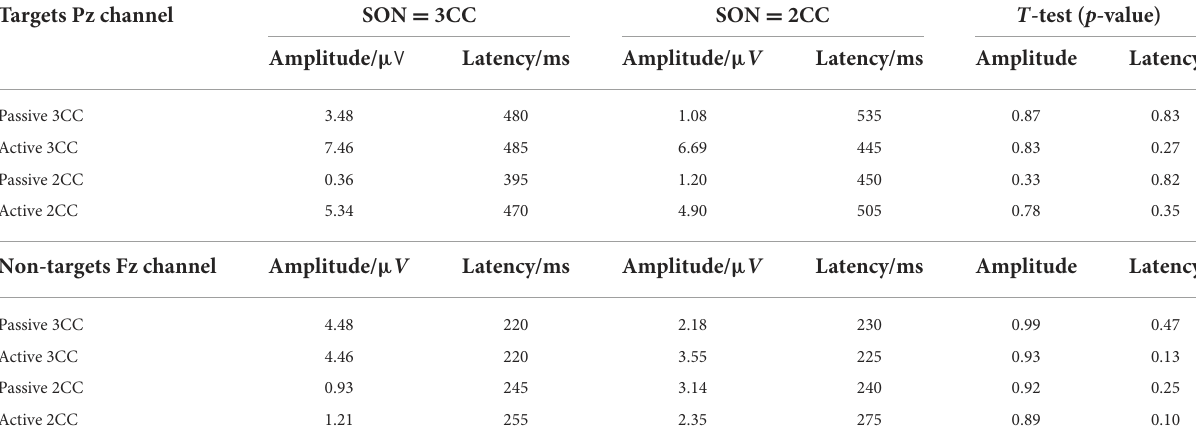
TABLE 1 The mean amplitudes and latencies as well as the t -test results.